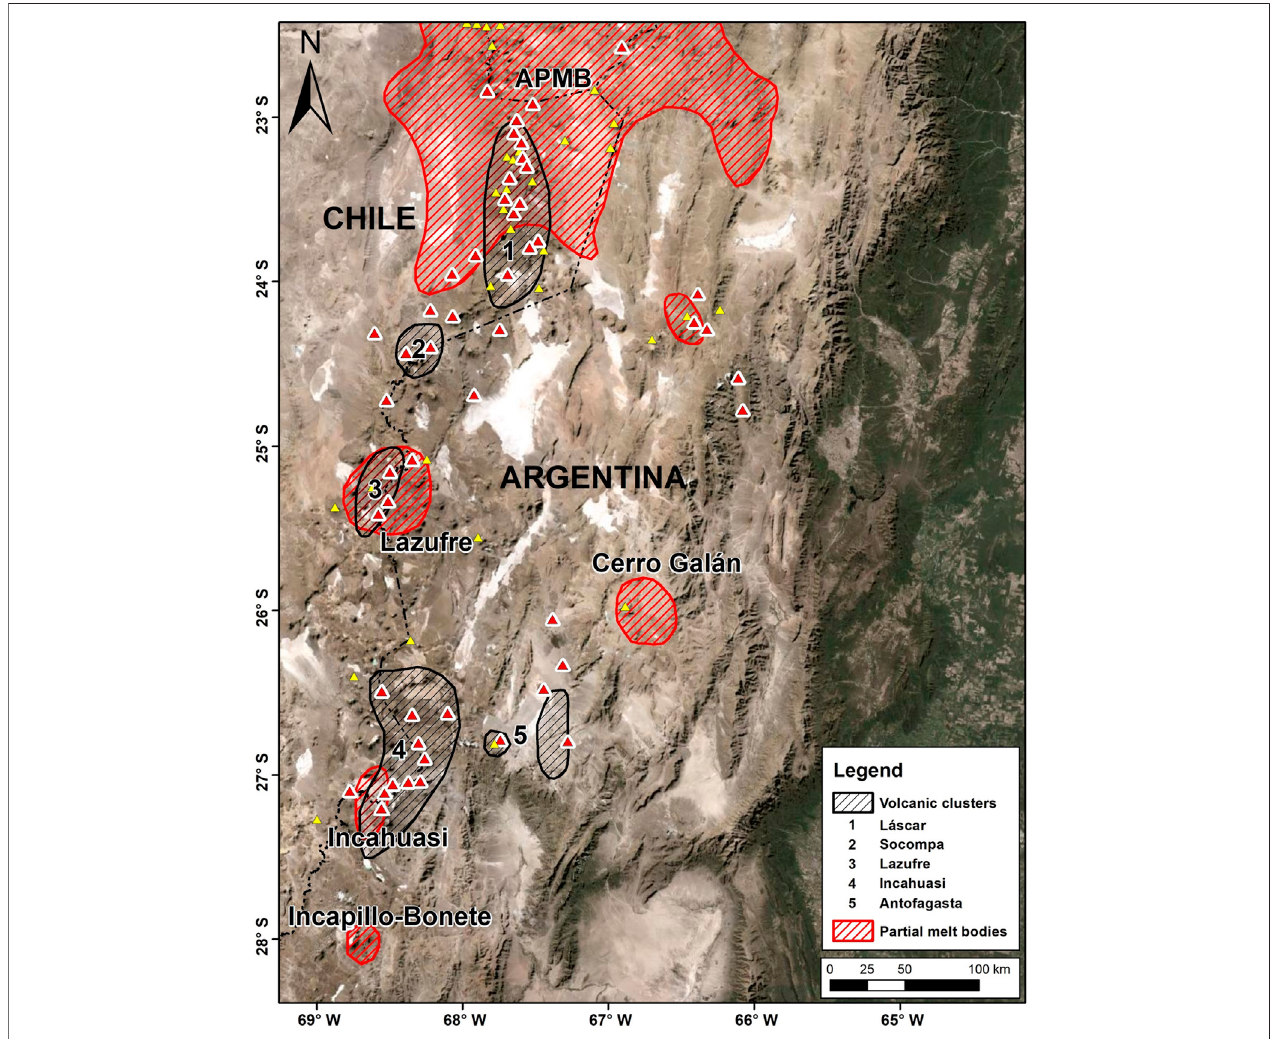
FIGURE9| Theapproximateextentofthe fi veclustersidenti fi edinthiswork(blackstripedregions,basedonthe0.6probabilityisocontoursfrom Figure3B ),along withthemid-to-uppercrustalpartialmeltbodiesidenti fi edintheregionbyWardetal.(2017)(redstripedlabelledregions;APMB:Altiplano-PunaMagmaticBody).Yellow and red triangles correspond to the Plio-Pleistocene and Pleistocene-Holocene volcanoes in the region, respectively, modi fi ed from Siebert et al. (2010). Minor monogenetic fi elds/centres have been included as well.